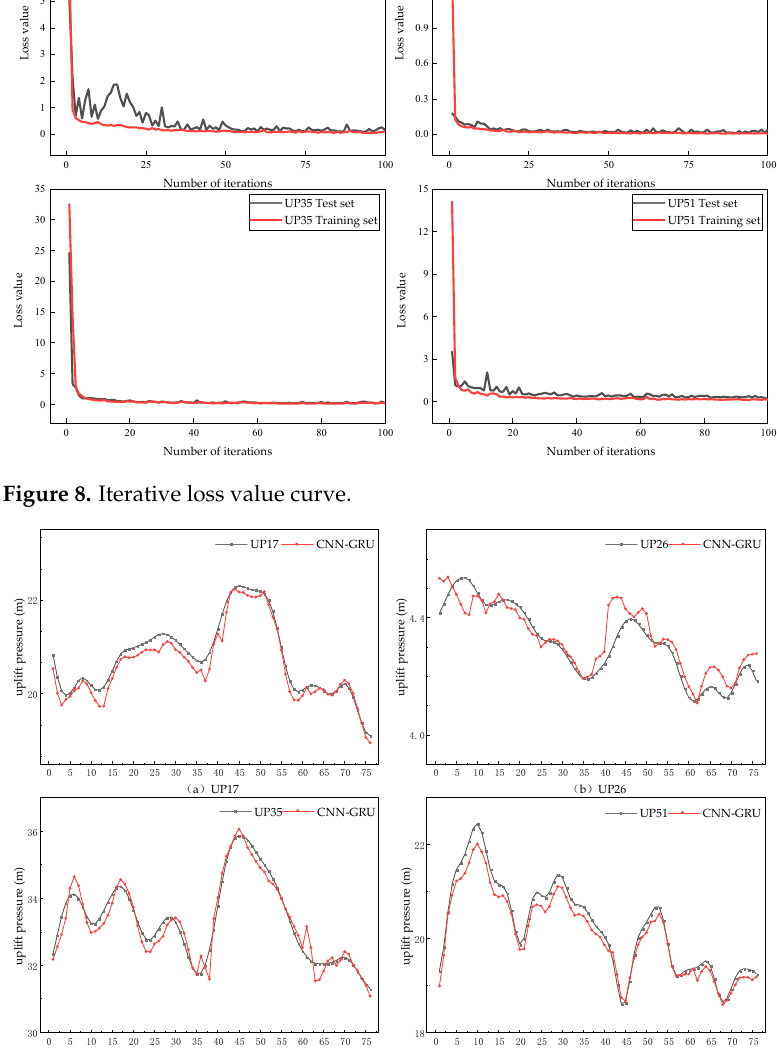
Figure 9. Uplift pressure predicted results. (( a ): Prediction results of CNN-GRU model in the UP17 measurement point; ( b ): Prediction results of CNN-GRU model in the UP26 measurement point; ( c ): Prediction results of CNN-GRU model in the UP35 measurement point; ( d ): Prediction results of CNN-GRU model in the UP51 measurement